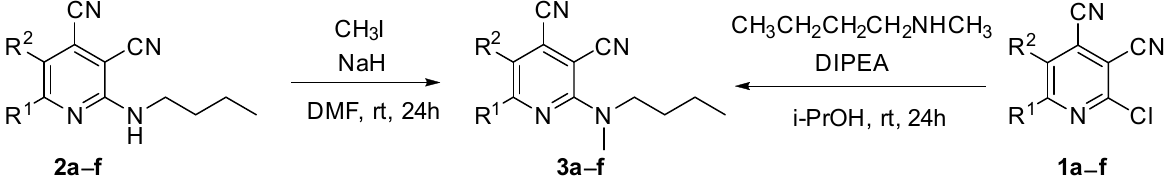
Scheme 2. Synthesis of 2-(butyl(methyl)amino)pyridine-3,4-dicarbonitriles 3. The synthesized 2-(butyl(methyl)amino)pyridine-3,4-dicarbonitriles 3 also exhibited